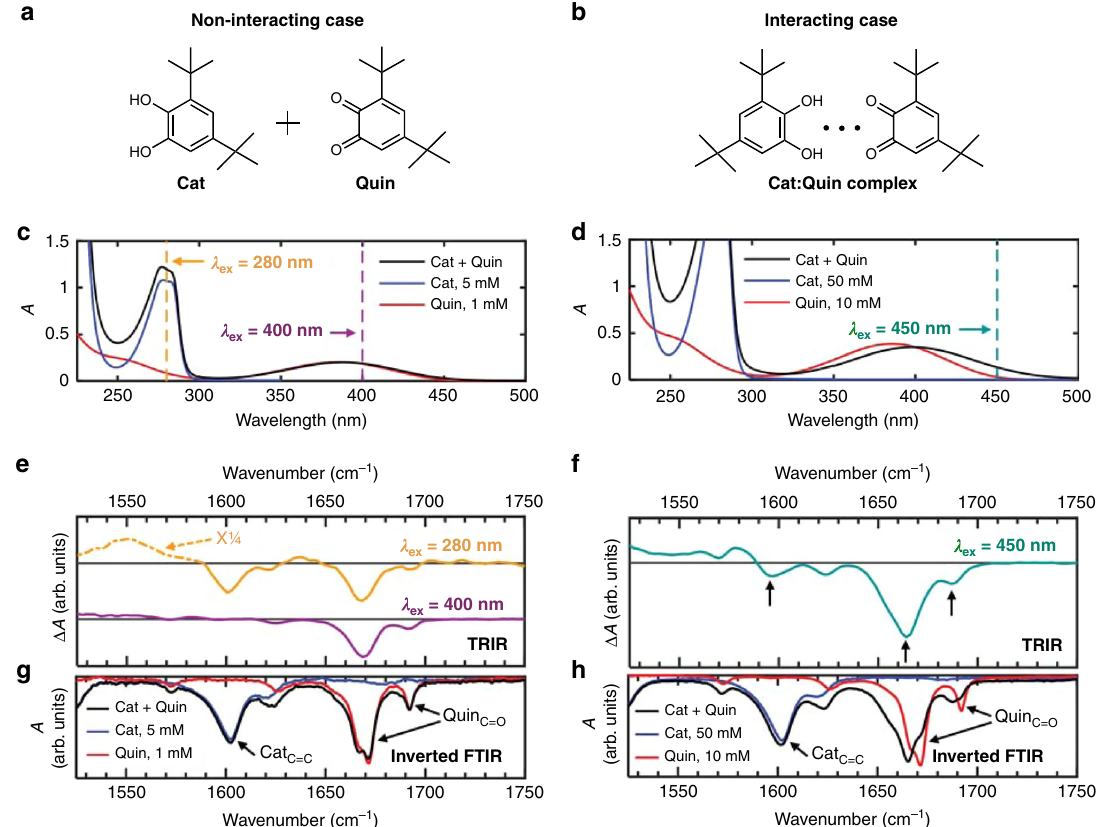
Fig. 2 Ultrafast vibrational fi ngerprinting demonstrated for a model system. Solutions of catechol (Cat) and quinone (Quin) mixtures in cyclohexane contain either a non-interacting, isolated molecules, or b molecules interacting through intermolecular hydrogen bonds. The Cat:Quin mole ratios were fi xed at 5:1. a , b Chemical structures of Cat and Quin. c , d UV-vis spectra of cyclohexane solutions of Cat, Quin, and their mixtures, highlighting the excitation wavelengths used in time-resolved infrared (TRIR) spectroscopy experiments. The cell pathlengths used in c and d were 1 mm and 200 μ m, respectively. e , f TRIR spectra of the mixture solutions averaged from 1 – 2 ps, recorded at the indicated excitation wavelengths. g , h Inverted FTIR spectra of cyclohexane solutions of Cat, Quin, and their